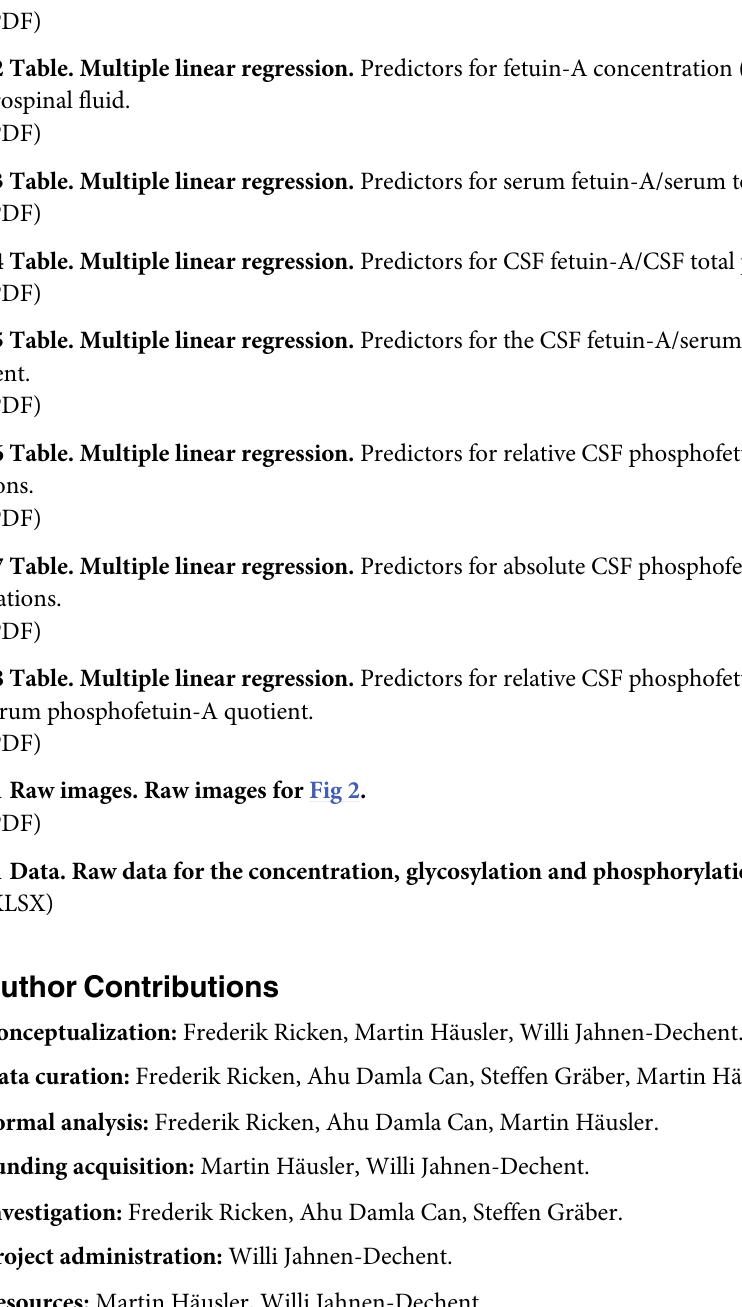
S1 Table. Multiple linear regression. Predictors for fetuin-A concentration (mg/ml) in serum. S2 Table. Multiple linear regression. Predictors for fetuin-A concentration ( μ g/ml) in cere- brospinal fluid. S3 Table. Multiple linear regression. Predictors for serum fetuin-A/serum total protein ratio. S4 Table. Multiple linear regression. Predictors for CSF fetuin-A/CSF total protein ratio. (PDF) S5 Table. Multiple linear regression. Predictors for the CSF fetuin-A/serum fetuin-A quo- tient. S6 Table. Multiple linear regression. Predictors for relative CSF phosphofetuin-A concentra- tions. S7 Table. Multiple linear regression. Predictors for absolute CSF phosphofetuin-A concen- trations. S8 Table. Multiple linear regression. Predictors for relative CSF phosphofetuin-A/relative serum phosphofetuin-A quotient. S1 Raw images. Raw images for Fig